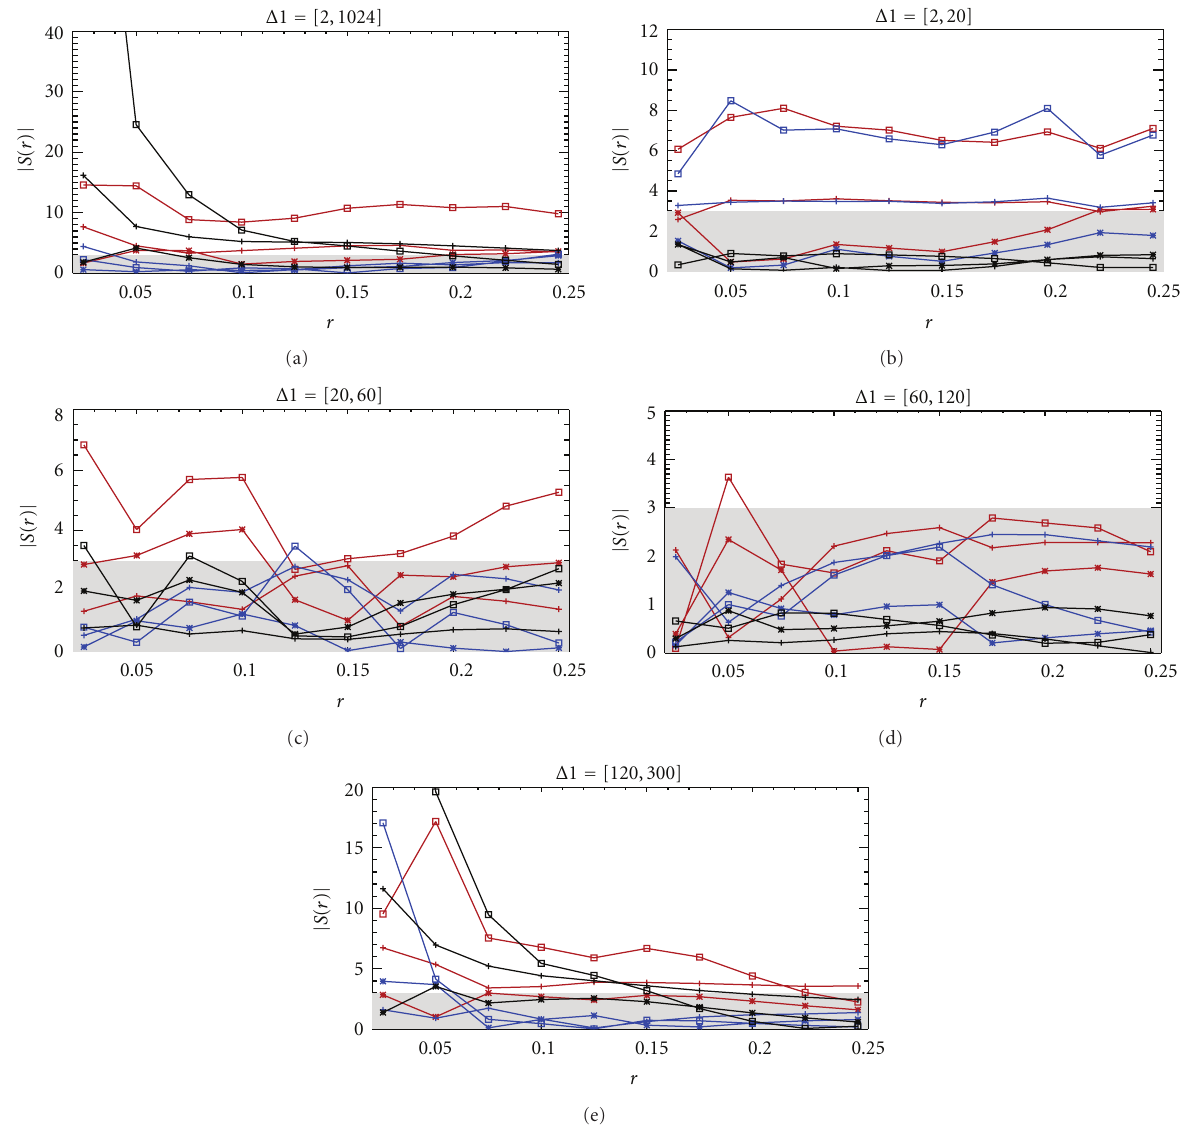
Figure 14: Deviations | S ( r ) | for the ILC7 map and the considered (cid:9) − intervals as a function of the scale parameter r for the full sky (black) and the upper (red) and lower (blue) hemispheres. The “+” symbols denote the results for the mean (cid:2) α ( r k ) (cid:3) , the “ ∗ ” symbols for the standard , and the boxes for the χ 2 -combination of (cid:2) α ( r k ) (cid:3) and σ α ( r deviation σ α ( r k ) k )